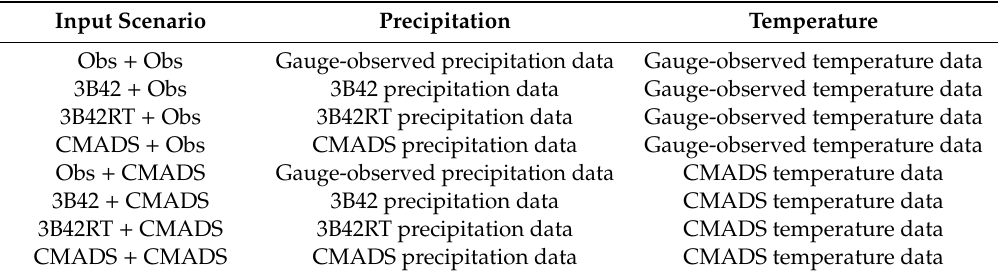
Table 1. Input Scenarios setting for the Soil and Water Assessment Tools (SWAT)